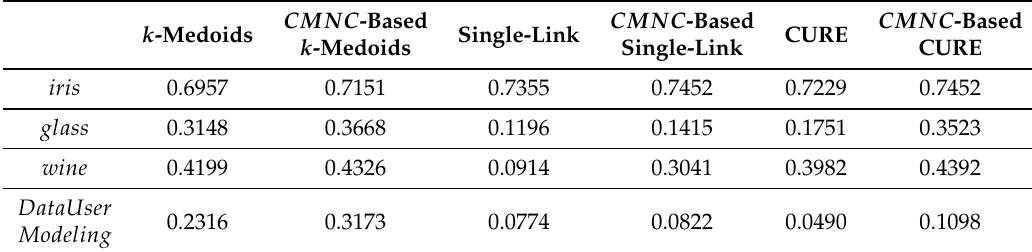
Table 2. Normalized Mutual Information (NMI) results of the tested